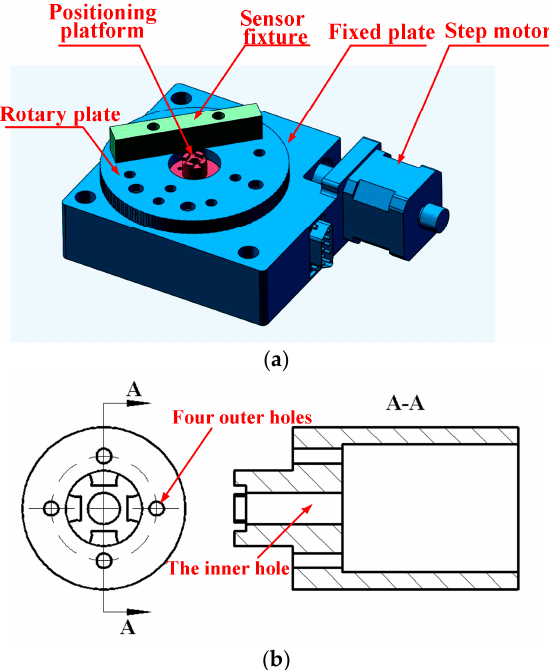
Figure 8. ( a ) Measurement platform; ( b ) Positioning platform.